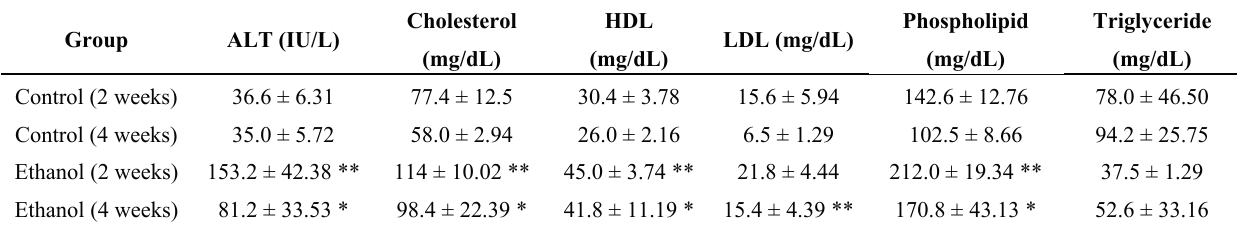
Table 2. Serum biochemical marker levels in pair-fed rats for four